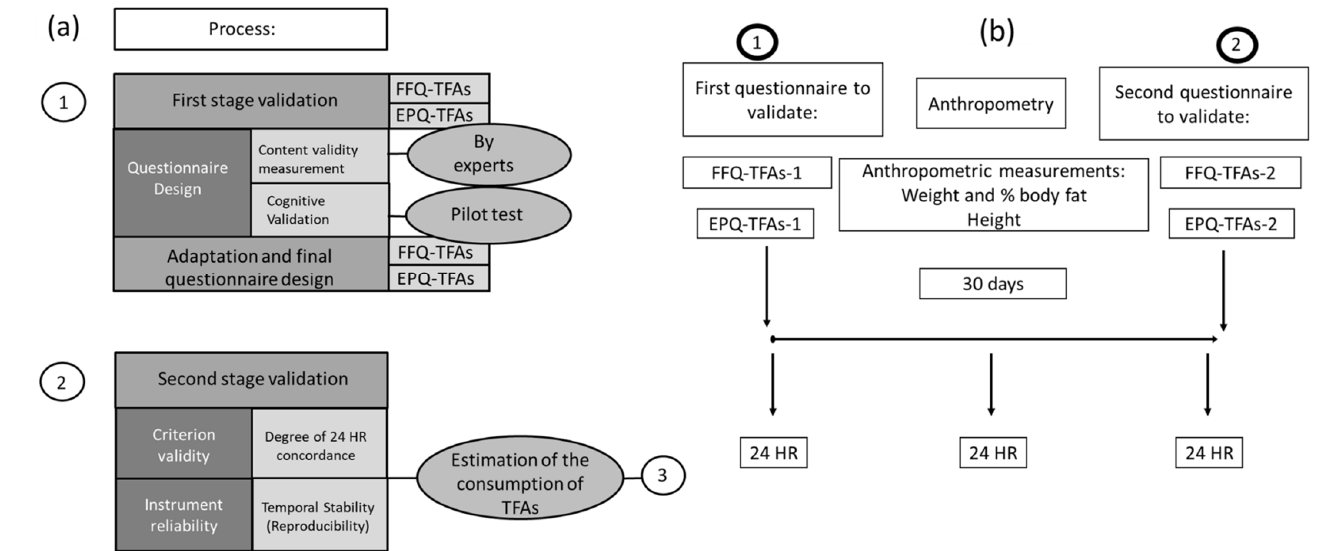
Figure 1. Stages of the study ( a ). Application of final questionnaires and 24 HR. Data collection and validation ( b ).